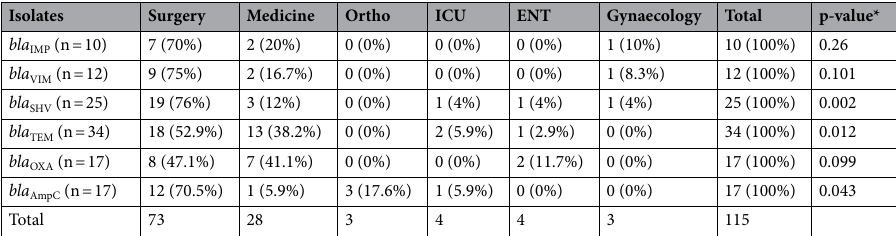
Table 4. Prevalence of MBL- and ESBL-producing Pseudomonas aeruginosa in correlation with department. Vertical ranking shows antibiotic resistance genes. Horizontal ranking shows department of sample collection. *p value ≤ 0.05 was considered statistically significant.